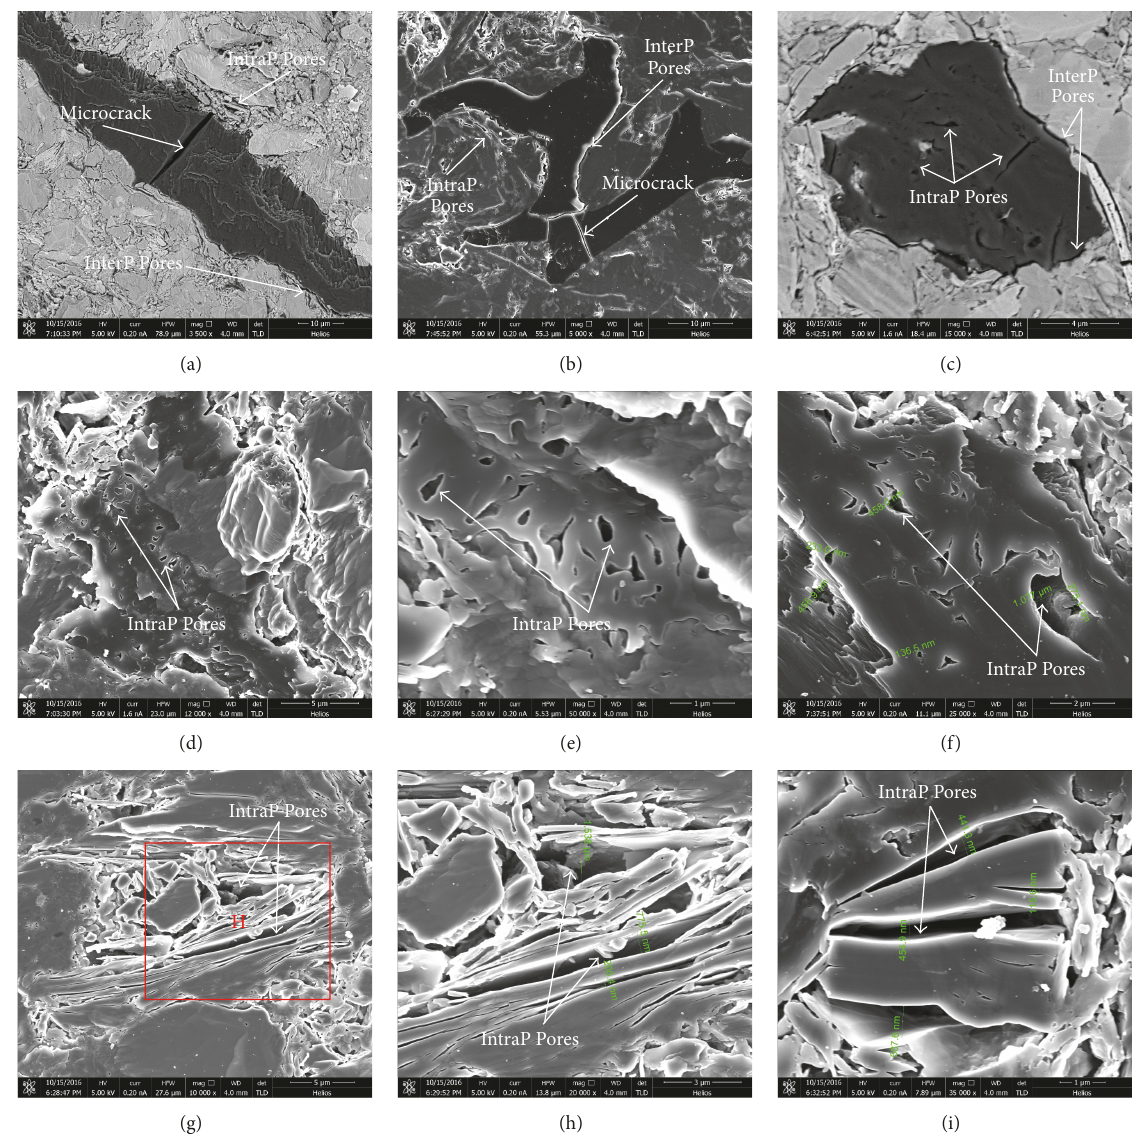
Figure 4: The FIB-SEM images of sample NT-M2 ( 𝜑